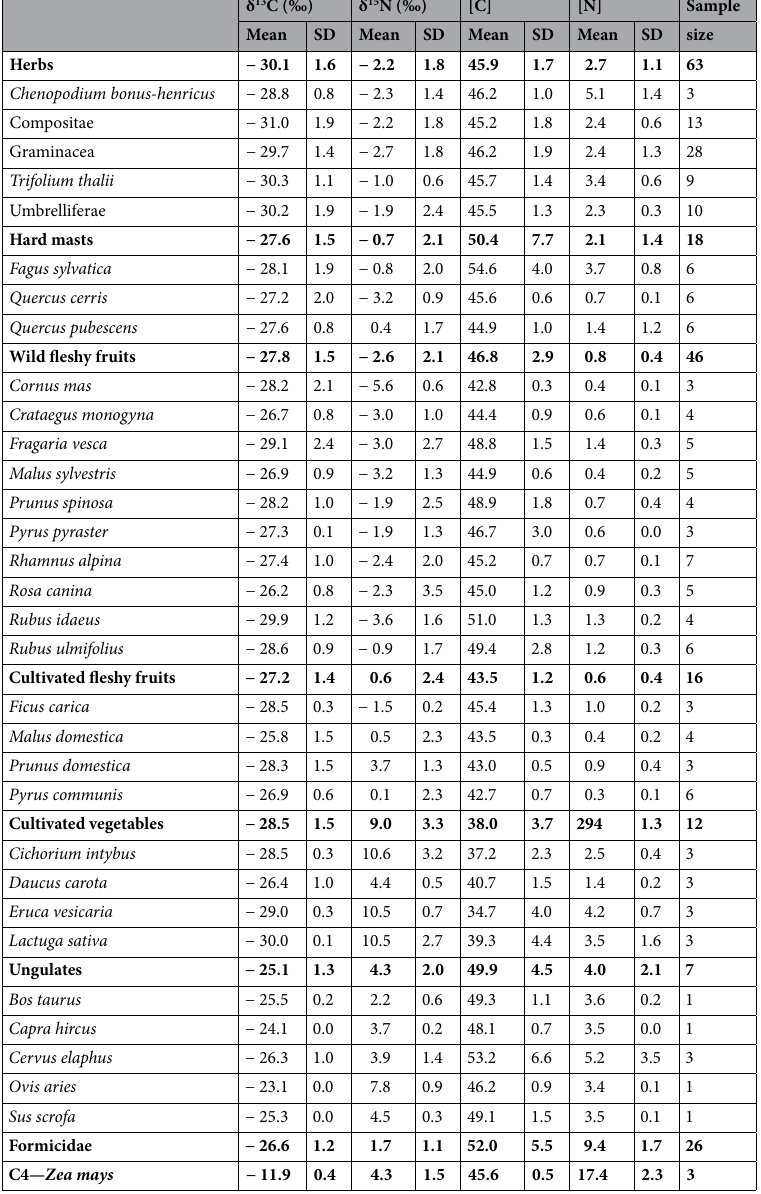
Table 1. Mean isotopic ratios and elemental concentrations for sampled Apennine bear key foods in the National Park of Abruzzo Lazio and Molise, central